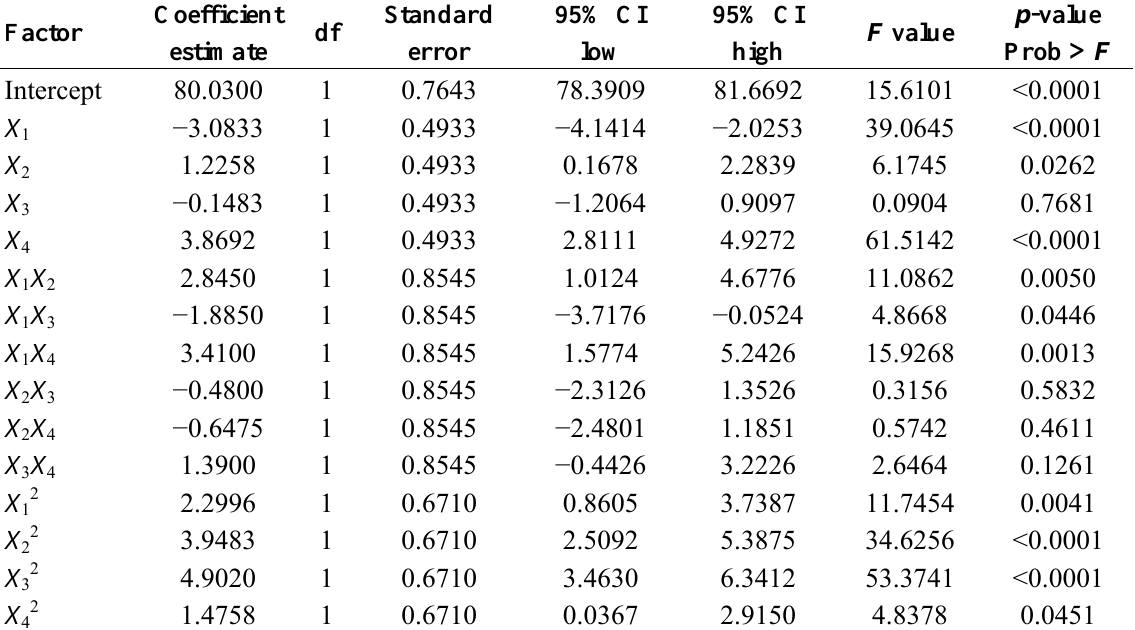
Table 3. Significance test for regression